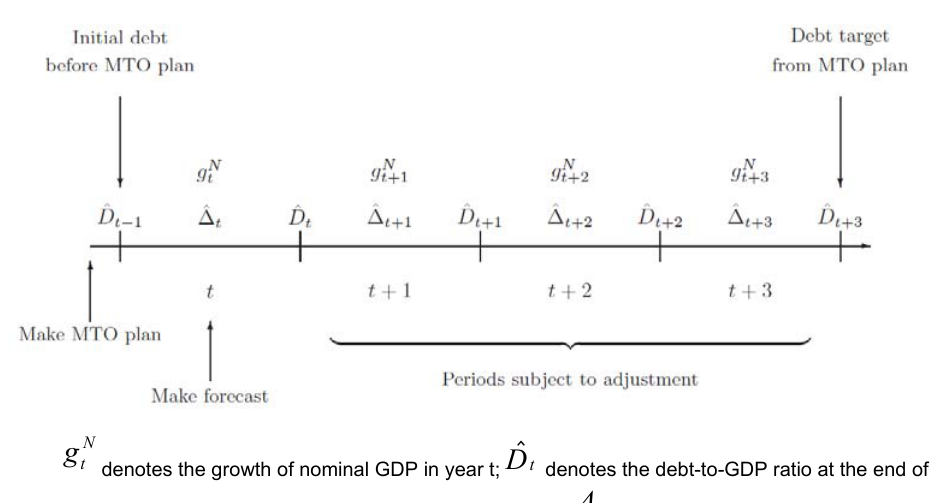
Figure 2. Timeline of